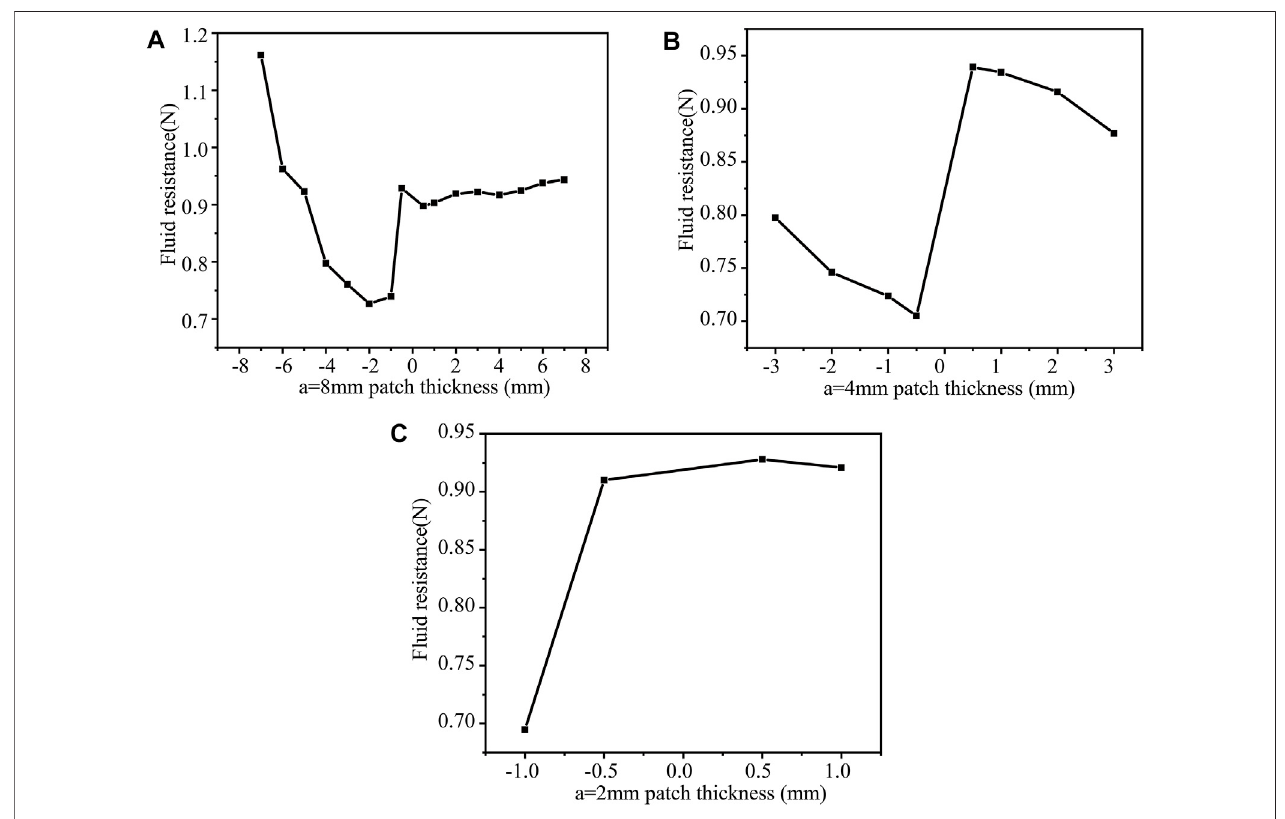
FIGURE 9 | b = 4 mm, the drag force under different patch numbers and different thickness patches (A) a = 8 mm; (B) a = 4 mm; (C) a = 2 mm.